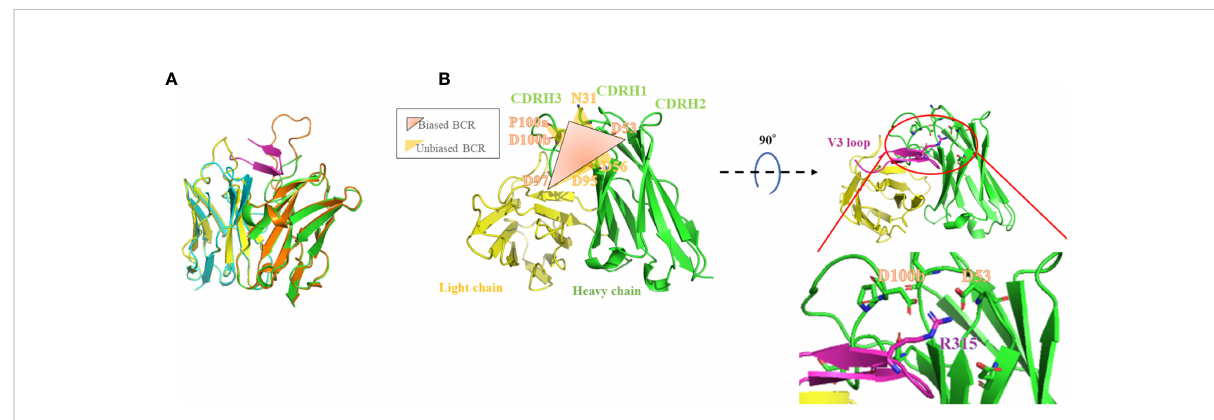
FIGURE 6 1C10 homology model illustrates contact residues on the adapted structure located close to the V3 tip region. The crystal structure of 1334 (PDB: 6db7) is superposed onto the 1C10 homology model. Heavy and light chains of 1334 are drawn as orange and light blue ribbons, respectively, and those of 1C10 are light green and light blue, respectively, and the V3 loop is magenta (A) . The structures composed by the correlated amino acids (AAs) in biased BCRs and unbiased BCRs are drawn in the 1C10 homology model as graduated dark orange triangles consisting of D53, D97, and PD, and yellow triangles consisting of N31, D56, and D97, and D53, D95, and D97, respectively (left). The positions of D53 of 1C10 CDRH2, D100b of 1C10 CDRH3, and R315 of the V3 loop are also depicted in the homology model (right) (B) . AAs are annotated by Kabat